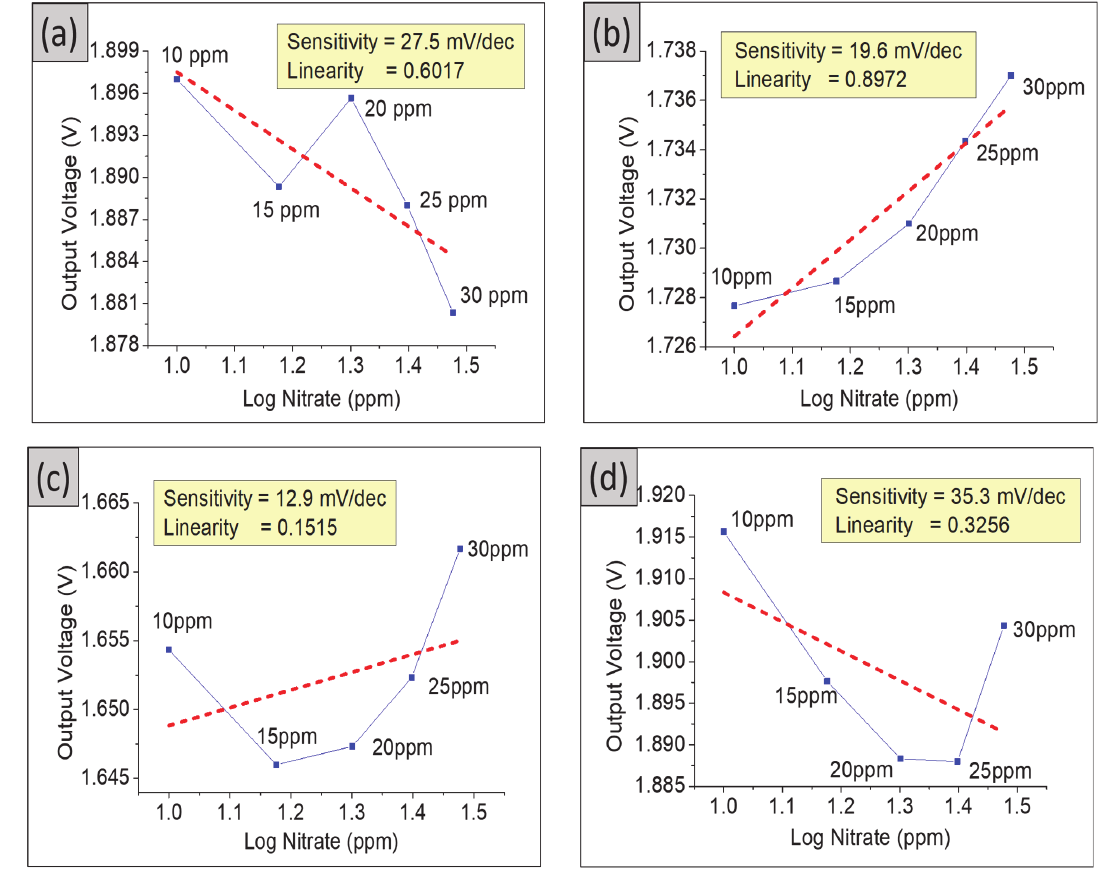
9 of 16 Figure 5. Output characteristics (I DS –V DS ) and sensitivity in saturation region for ( a , b ) TiO 2 thin film, ( c , d ) TiO 2 –PANI bilayer composite, ( e , f ) TiO 2 –PANI composite thin films, and ( g , h ) ITO substrate. 2.2.2. Selectivity Test in pH Measurement